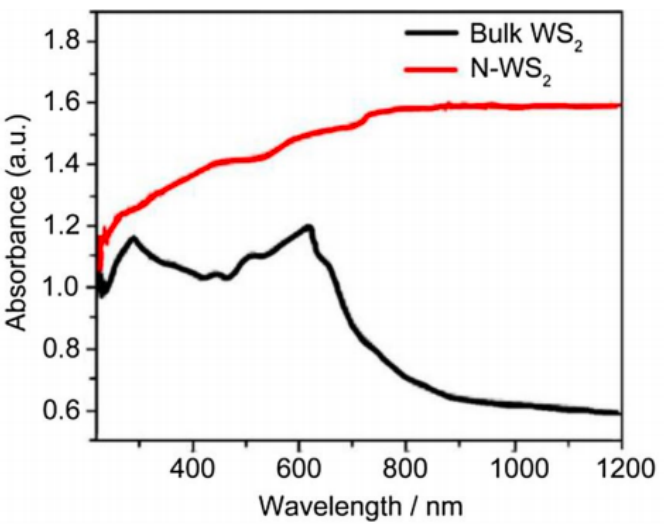
Figure 4. UV ‐ Vis ‐ NIR absorption spectra of nanosheets WS 2 and bulk WS 2 . Reproduced with per ‐ Figure 4. UV-Vis-NIR absorption spectra of nanosheets WS 2 and bulk WS 2 . Reproduced with mission. [82] Copyright 2015, Wiley VCH . permission [82]. Copyright 2015,